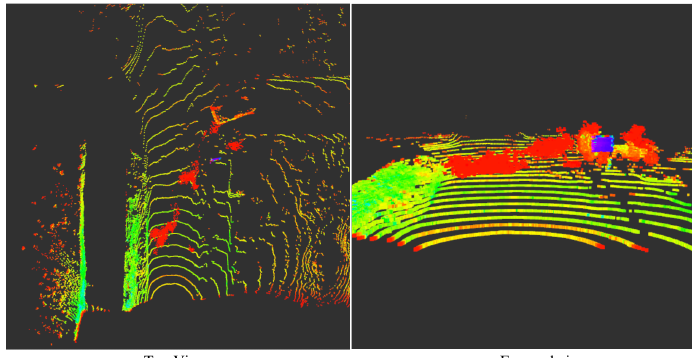
Figure 11. Point cloud in dust scene.